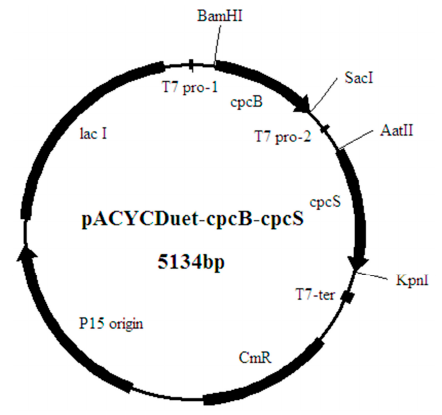
Figure 6. Plasmids of pET- hoxI-pcyA , pACYCDuet- cpcB and pACYCDuet- cpcB-cpcS . Table 3 . Name and source of strains and plasmids used in this study.